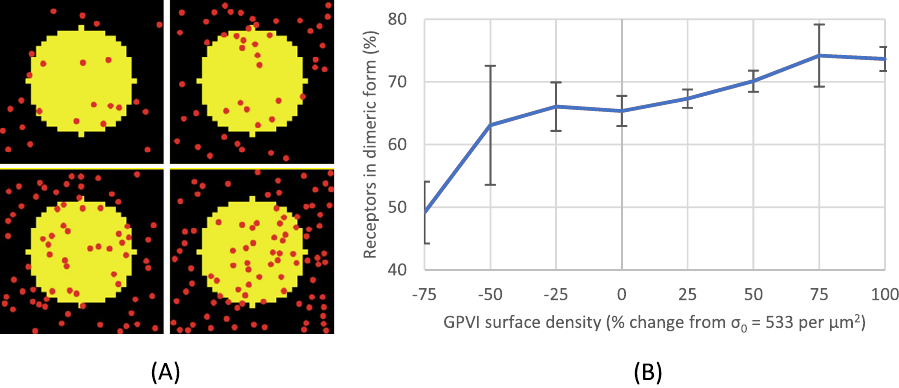
Figure 11. Increasing GPVI surface density increases dimerisation. ( A ) Simulation setups with various surface densities of GPVI: from left to right, top to bottom 50%, 100%, 150%, and 200% of σ 0 . ( B ) The plot shows that receptor dimerisation (as proportional to total GPVI, in %) increases with the GPVI surface density (as proportional to